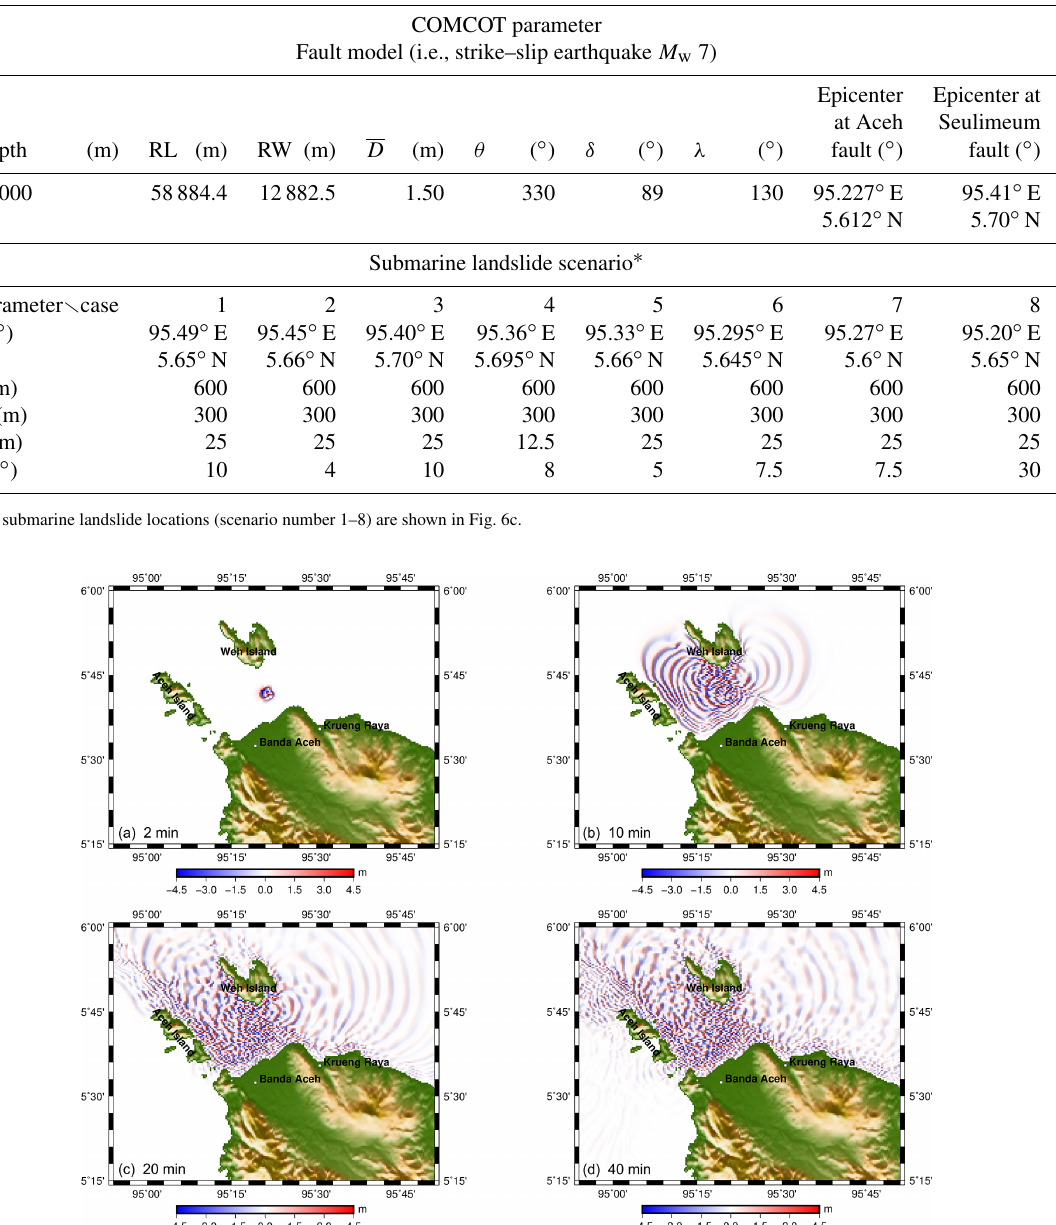
Table 2. COMCOT input parameter.